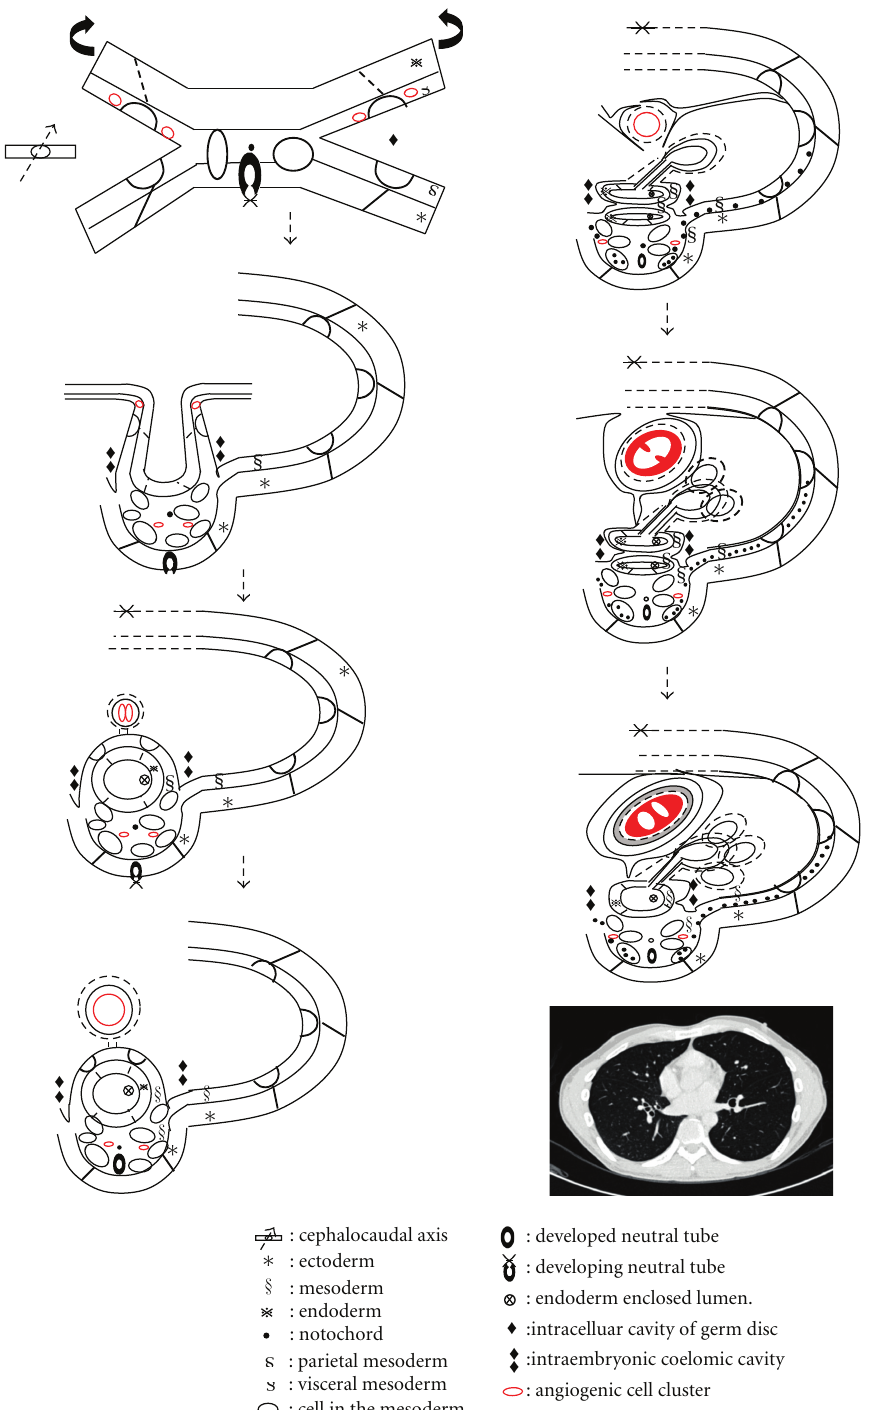
Figure 7: Heart and pericardial cavity formation. Diagram shows that bilateral angiogenic cell cluster originated from the mesoderm fused in the midline along with lateral folding of germ disc and forms the heart and the visceral pericardium. The parietal mesoderm then forms the fibrous and serous layer of parietal